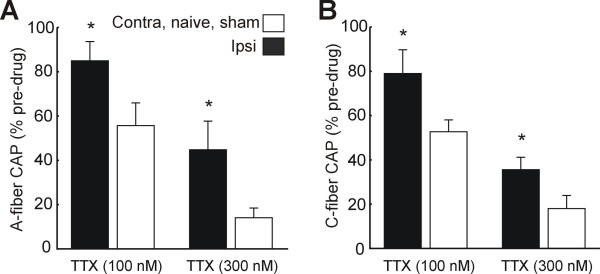
Increased TTX-resistance of the sciatic nerve after SNE. A: TTX-resistance of the A-fiber sciatic nerve compound action potential (CAP) ipsilateral to SNE (n = 8) compared to contralateral, naïve and sham surgery nerves (n = 8). CAP response is expressed as a % of recorded amplitude before TTX administration. A-fiber CAP stimulus was 0.1 mA, 0.1 ms throughout. B: Changes in TTX-resistance of the C-fiber sciatic nerve CAP after SNE. C-fiber CAP stimulus was 10 mA, 0.5 ms throughout. * indicates significant difference from control nerve sensitivity to TTX (p < 0.05, two-way ANOVA, Tukey post-hoc). Tissue was harvested 2 weeks after SNE or sham surgery.